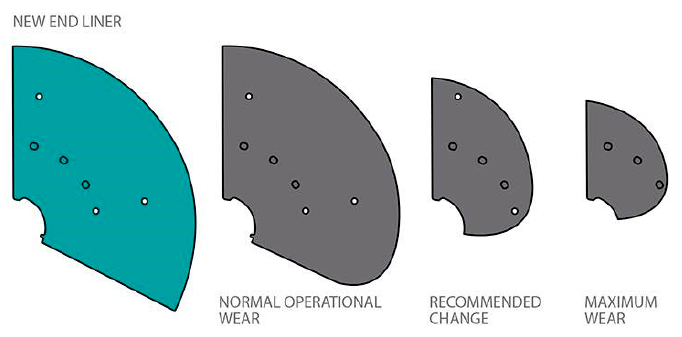
Figure 3. Wear pattern for the bottom liner [25].